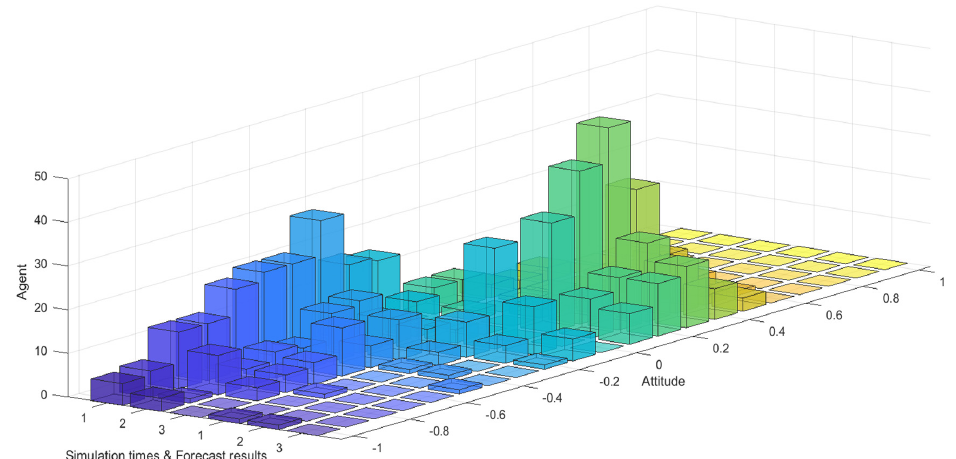
Figure 33. Simulated public opinion evolution diagram based on the literature [14]. Healthcare 2020 , 8 , x